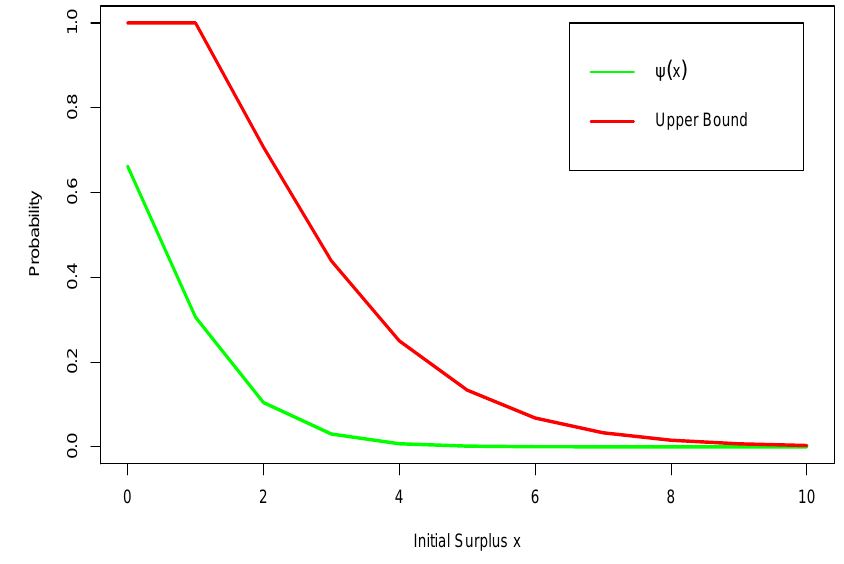
Figure 3. Ruin probability for model of Example